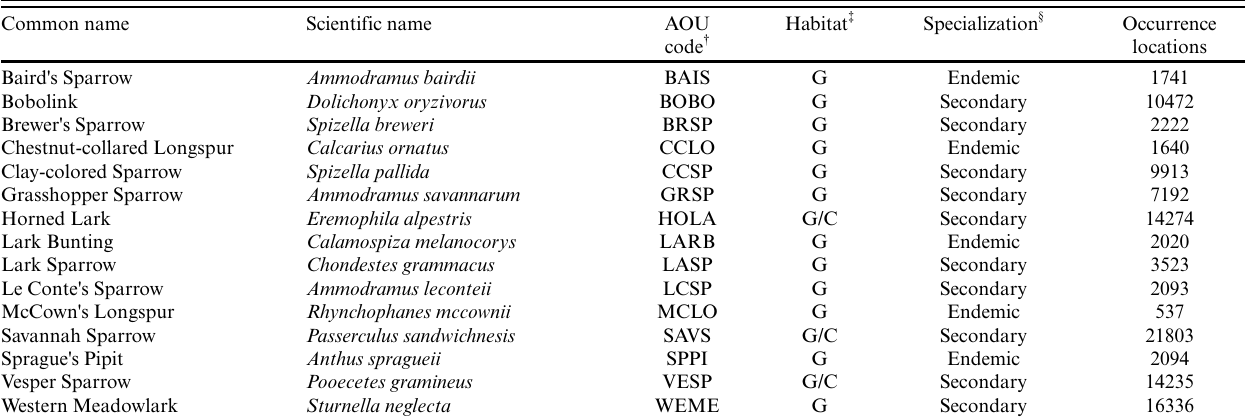
Table 1 . Habitat use, specialization, and number of occurrences used in climate suitability modeling for 15 grassland songbird species. Common name